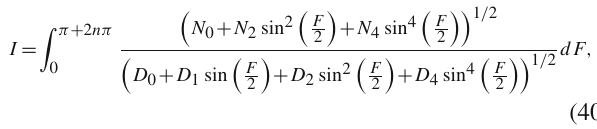
of “bumps” in the charge density is respectively ( 2 n + 1 ) and ( 2 m ) for configurations of the type (23) and (24). The Fig. 2, in which we adopted periodic boundary conditions (24), represents the cell of a crystal. The building block of such a crystal has two bumps of charges p and − p so